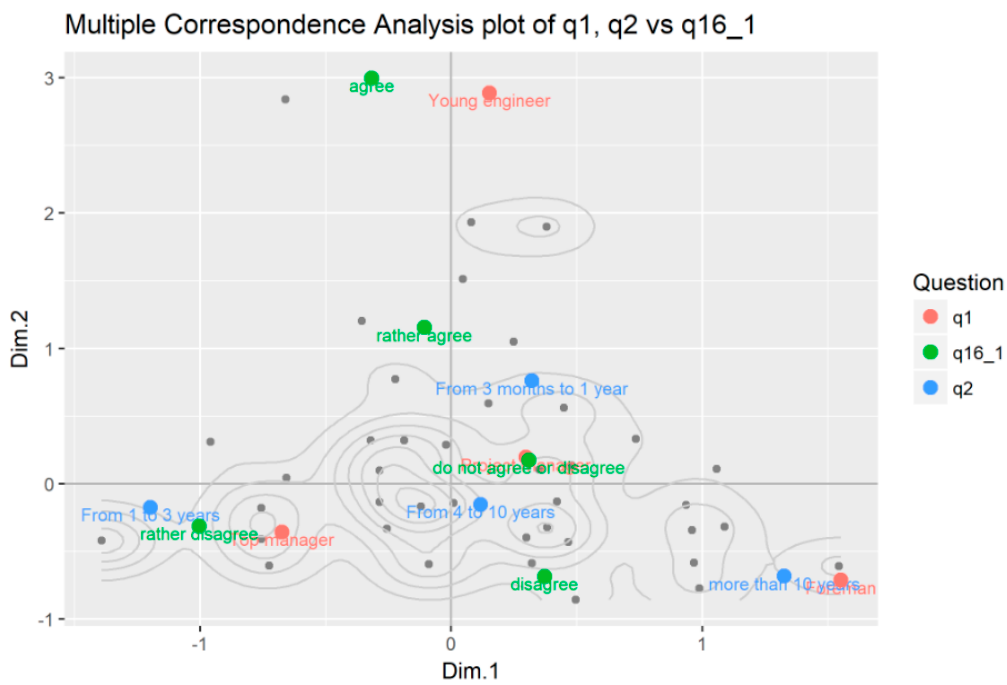
Figure 4. Answers to the question: My colleagues work independently after graduation.